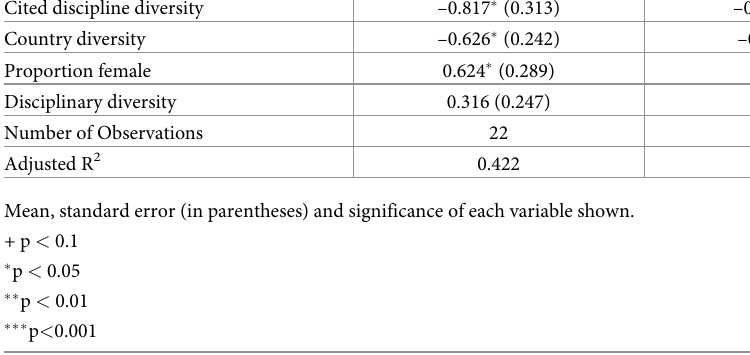
Mean, standard error (in parentheses) and significance of each variable